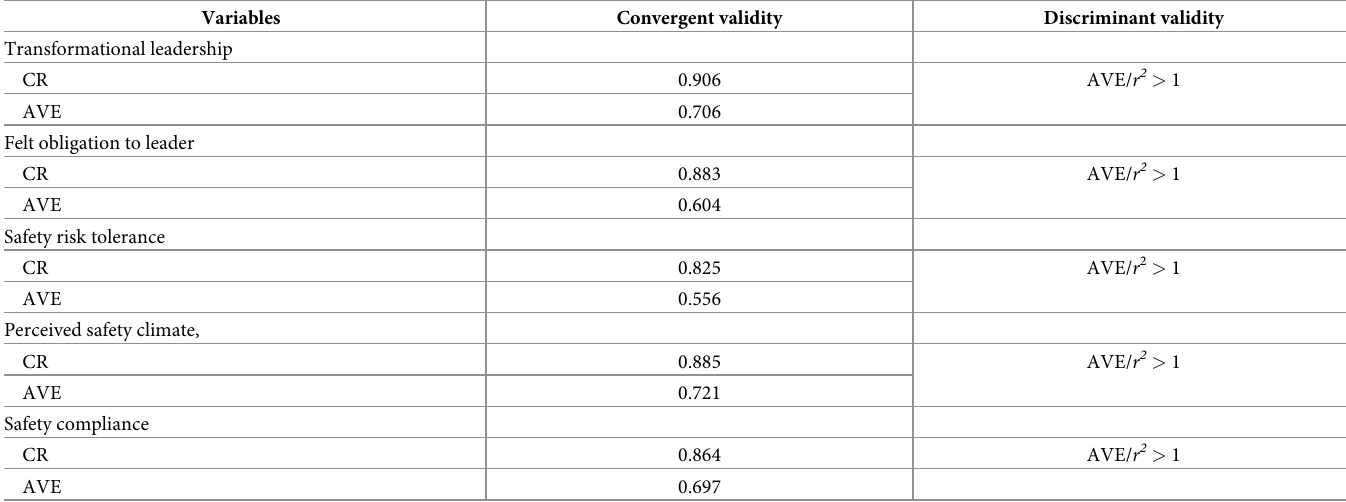
Table 2. Tests for convergent and discriminant validity.